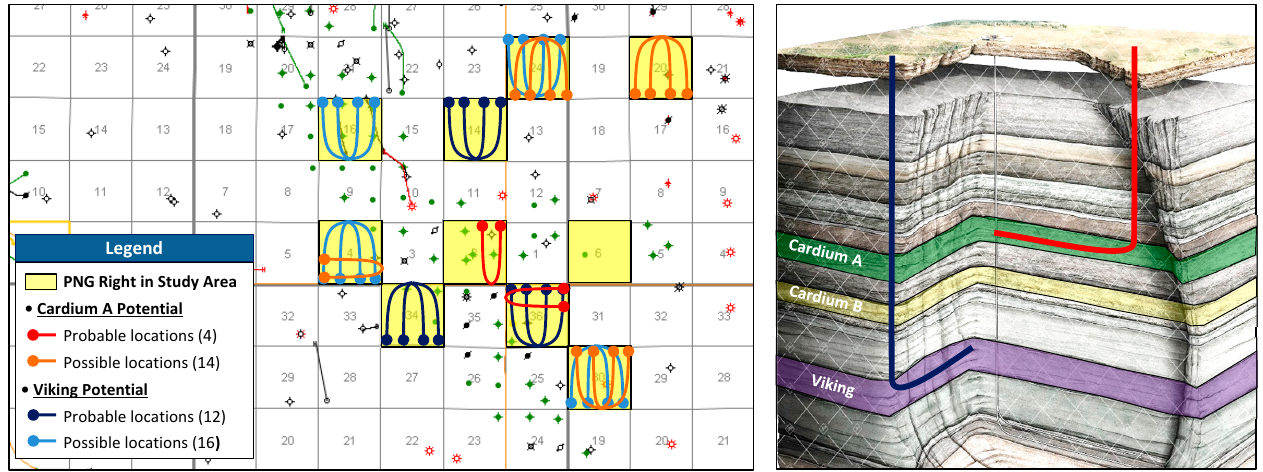
Figure 11. Elkton development potential in the study area.